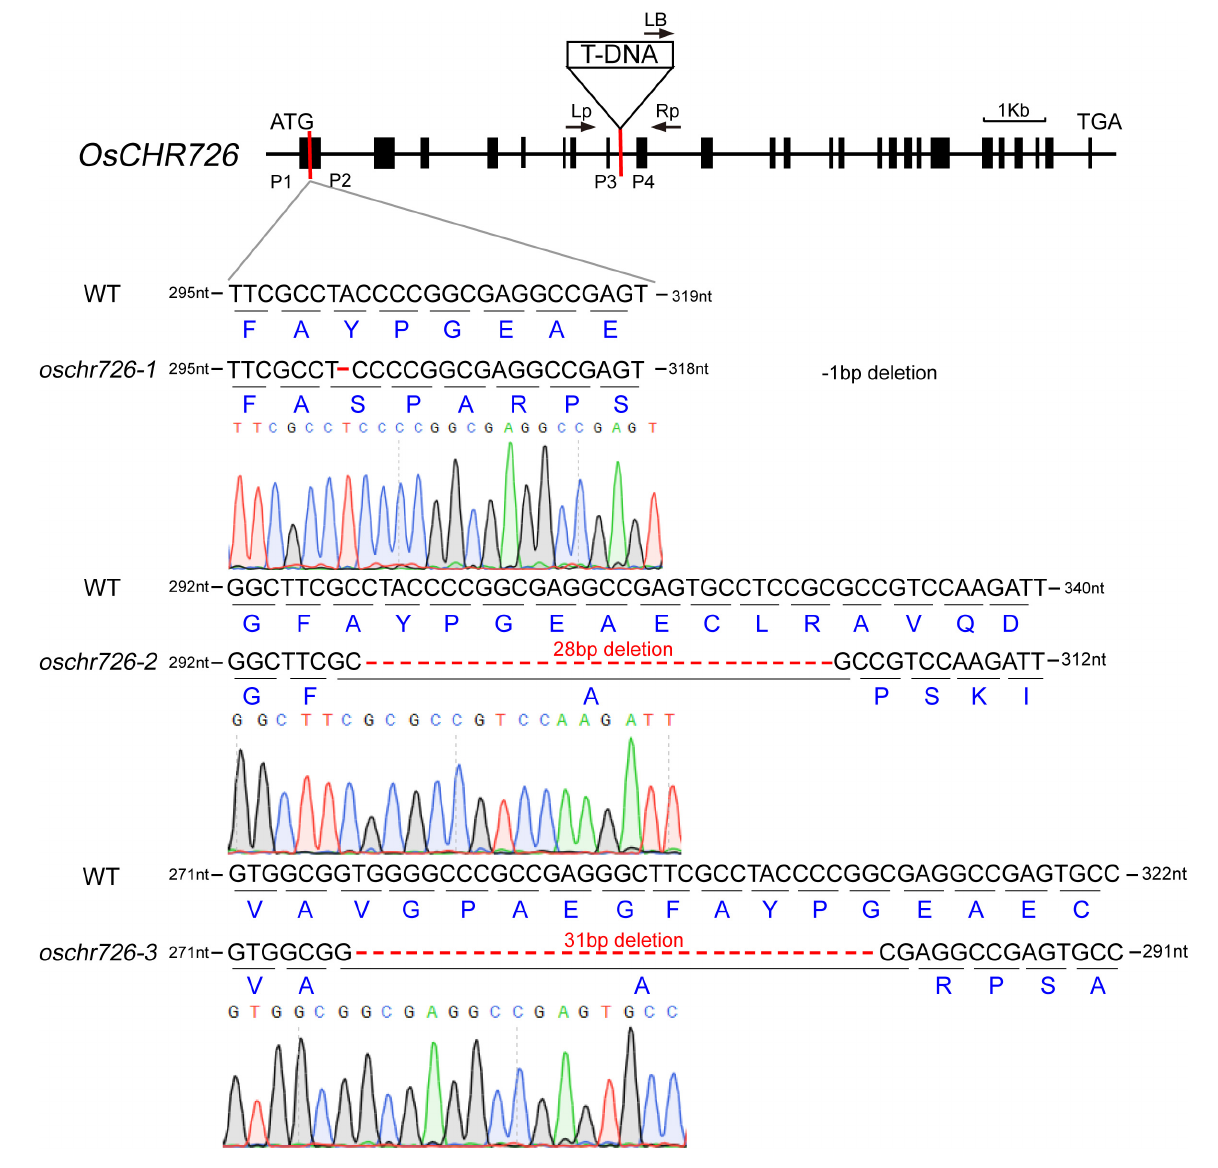
FIGURE 8 | Genotyping analysis of oschr726 . The triangle indicated the T-DNA insertion site in gene structure of OsCHR726 . The arrows indicated the location of the primers for genotyping study of the T-DNA mutant. P3 and P4 were the positions of primers for identifying the transcription level of OsCHR726 in the T-DNA mutant by qRT-PCR. The primers of P1 and P2 were used for identifying the CRISPR/Cas9-mediated mutations in OsCHR726 in the T2 generation. The diagrams display the sequence results of the three CRISPR mutations. The black letters indicated the base pairs with WT in the target site. The dotted lines indicated nucleotide deletions, and dark blue letters indicated the amino acids encoded by the WT and oschr726